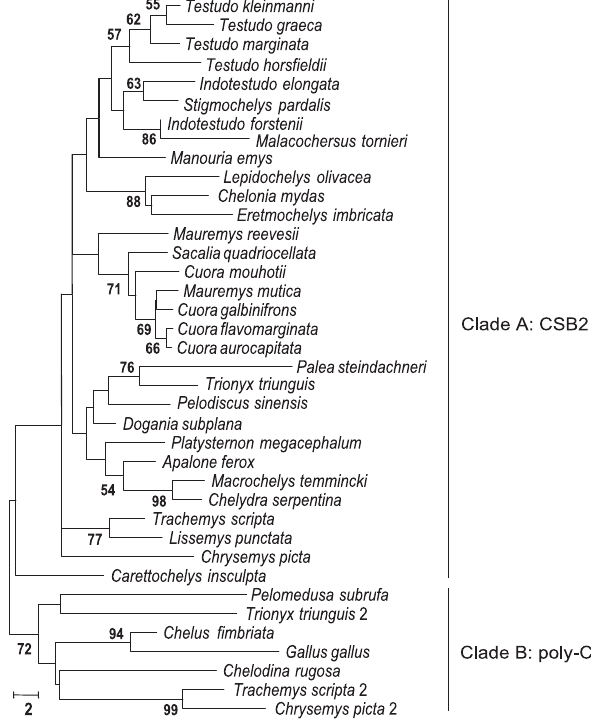
Figure 2. NJ tree based on the CSB2s and poly-C sequences. The tree was reconstructed according to S AITOU & N EI (1987) using the abso- lute number of differences in MEGA (K UMAR et al. 1993). Sequences used in the analysis are listed in the Appendix. A total of 1000 boot- strap replicates were performed and values greater than 50 are indi- cated at the respective nodes. Clade A consists of species in which CSB2 is located within the CSB domain, whereas clade B contains the species whose poly-C sequences are within the TAS